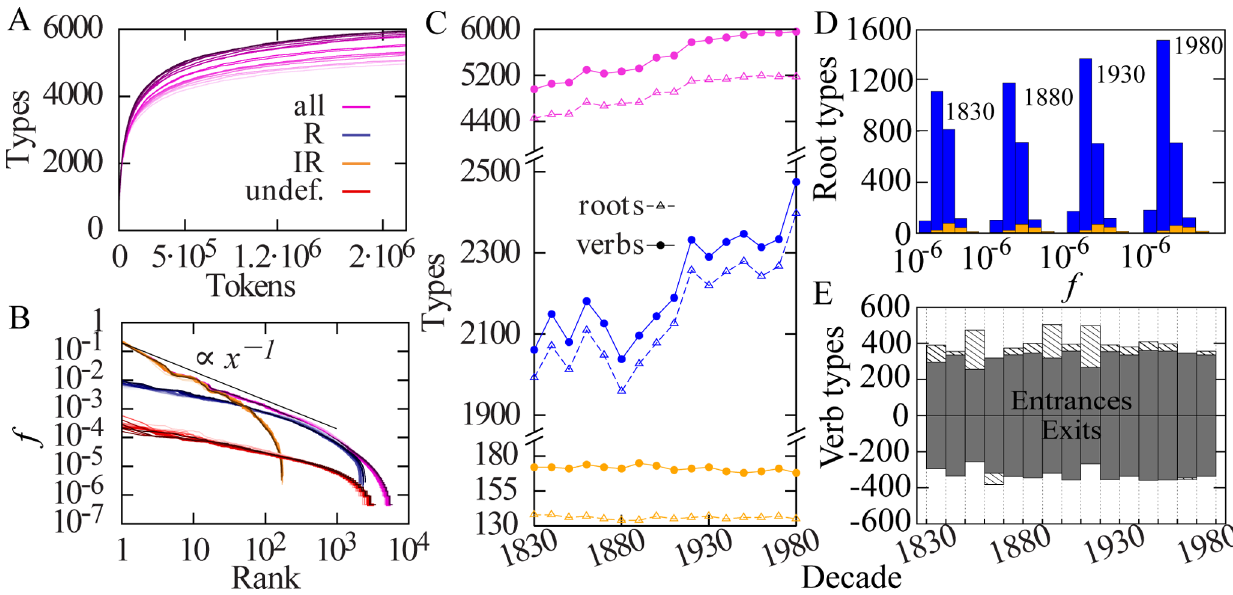
Figure 1. Language as an open system. Colors indicate the type of verb or root depicted: all verbs (purple), mostly regular (blue), mostly irregular (orange), and undefined (red). Lighter saturation of a colour indicates earlier decades, while darker saturation indicates later decades. Where relevant, decades are labelled with the first year, e.g., 1830–1839 is 1830. (A) The number of types versus the number of tokens for all verbs in each decade. Given an equal number of tokens, the increase in the number of types over time reflects a genuine increase in the number of verbs at fixed sample size. (B) Frequency-rank plot contrasting different kinds of verbs (all, mostly regular, mostly irregular, and undefined). Mostly irregular types constitute the highest frequency regime, undefined types constitute the lowest frequency regime. (C) Plot of the number of mostly regular types, mostly irregular types, and all types over time, both for verbs and roots. The number of mostly regular verb types or root types increases over time, while the number of mostly irregular verb and root types remains essentially constant. The sum of all types considered together is more than the sum of mostly regular and irregular types; this is due to this category encompassing undefined types. (D) Frequency distribution of mostly regular, mostly irregular, and undefined categories for root types in four decades, the starting point of the first frequency bin is indicated for each depicted decade. (E) Verb type birth and death by decade. Each bar refers to the entering (top) and exiting (bottom) number of verb types between two decades; lighter areas show the entrance/exit differential. E.g., the first bar depicts the exits after 1830–1839 and the entrances in 1840–1849. There are generally more verbs entering than exiting, indicative of the overall growth in the number of types.